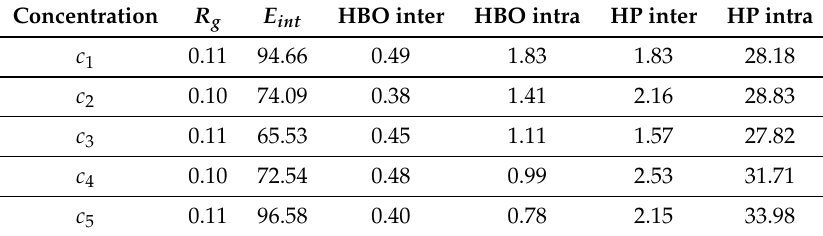
Table 1. Median of the standard deviation for the results presented in Figures 3–7.